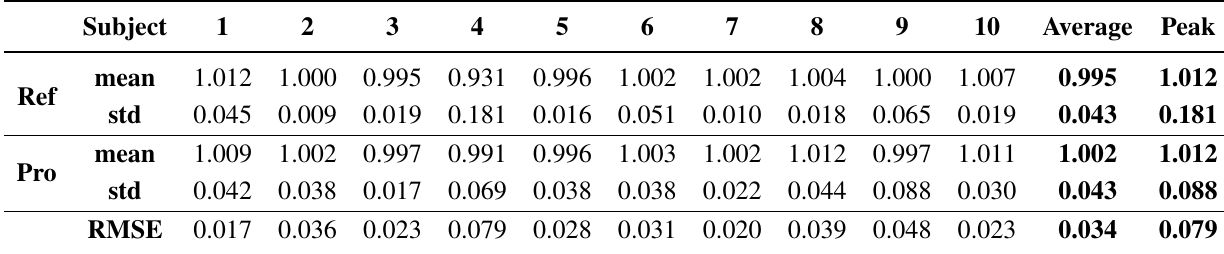
Table 6. Mean and standard deviation of the reference (Ref) and proposed (Pro) systems and RMSE in detecting vertical stride symmetry (vS) for each subject. Averaged values across the ten subjects are also